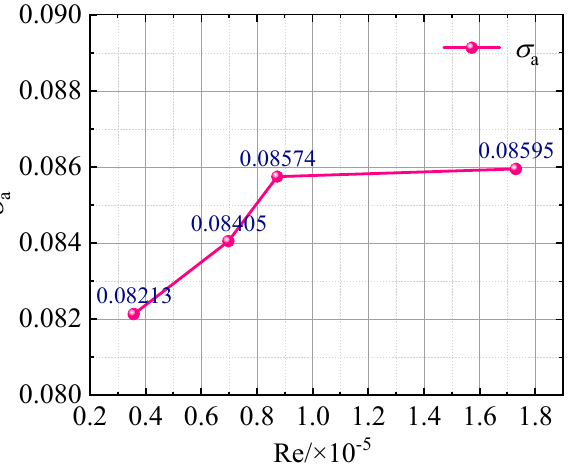
Figure 8. Relationship between cavitation number σ a and Re under head degradation rate of 3% ( Q d = 100 m 3 /h, n = 4500 rpm).